Question: Which kind of chart has been used to present this data?
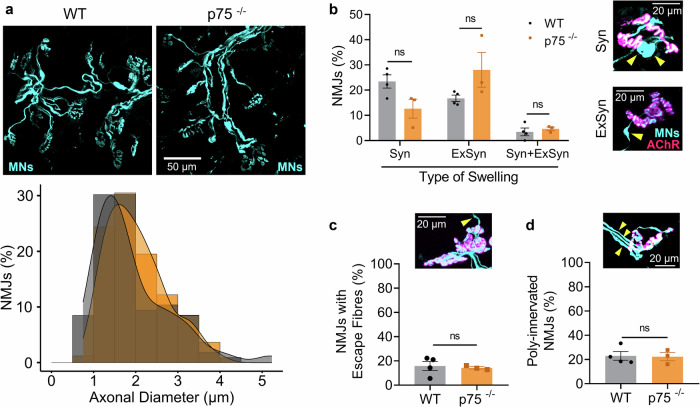
Answer: histogram